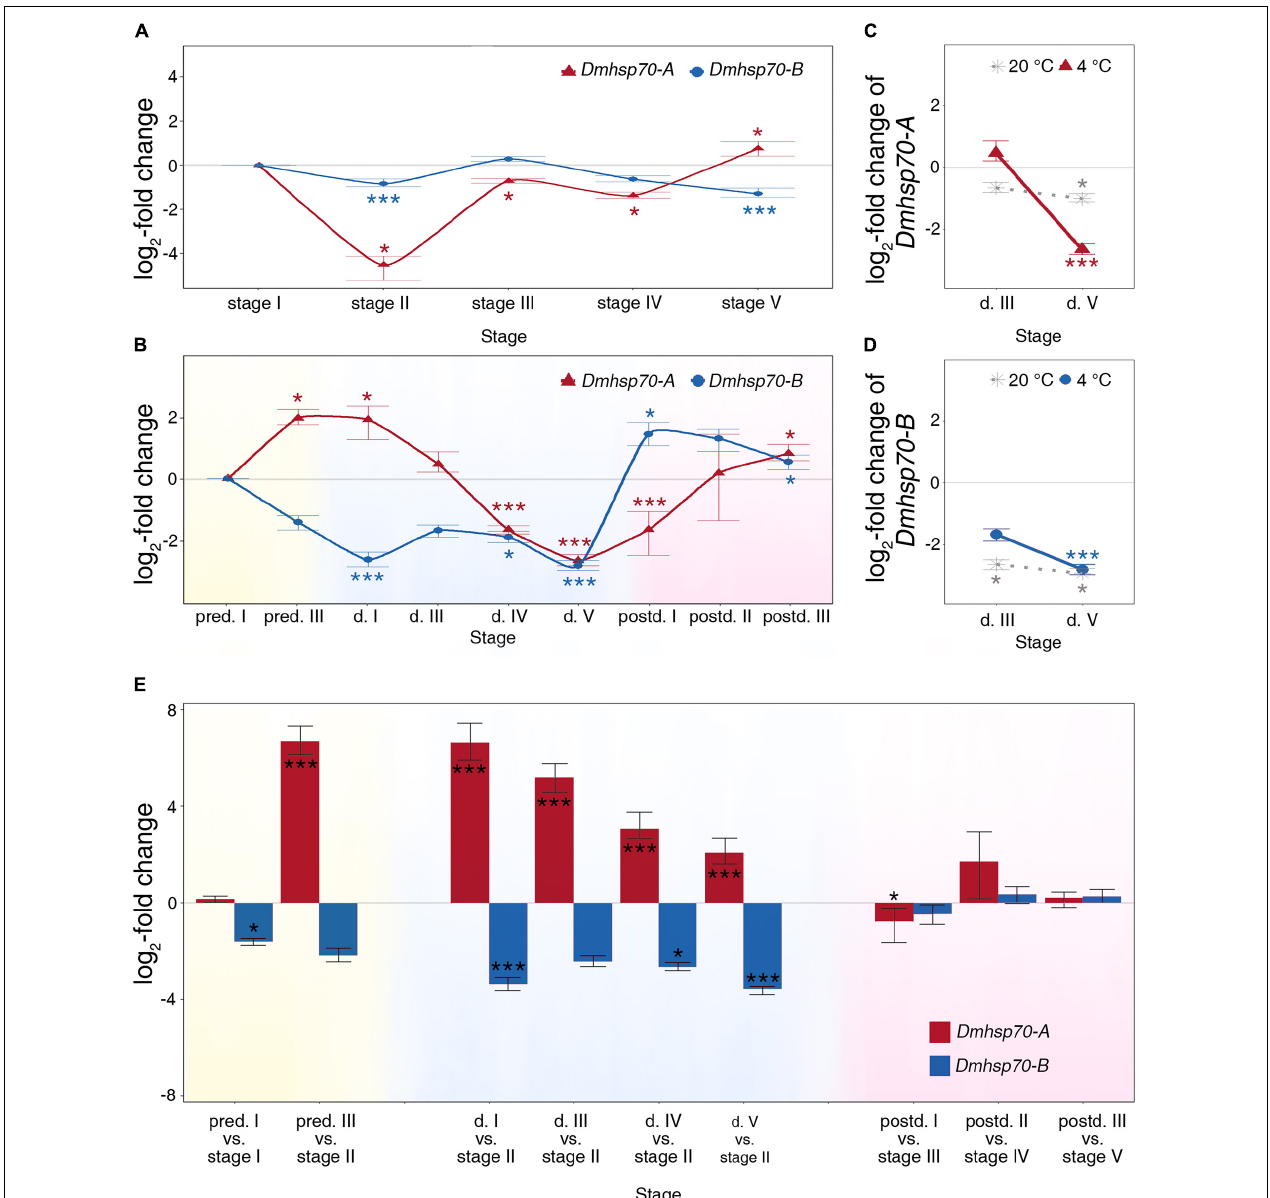
FIGURE 2 | Relative fold change (in log 2 scale) in transcript level of Dmhsp70-A and Dmhsp70-B. Dmhsp70-A and Dmhsp70-B during embryogenesis of asexually produced embryos (A) and sexually produced embryos (B) . Displayed is expression at each developmental stage relative to first stage (“stage I” in asexually produced embryos and “pred. I” in sexually produced embryos). Dmhsp70-A (C) and Dmhsp70-B (D) in 30-day-old diapausing embryos, which were stored at 20 ± 0.1 ◦ C. Displayed is expression at each developmental stage relative to “pred. I.” Comparison of gene expression of Dmhsp70-A and Dmhsp70-B (in log 2 scale) between asexually and sexually produced embryos (E) . Error bars represent standard error (n = 3). P -values are indicated by asterisks: * P ≤ 0.05, *** P ≤